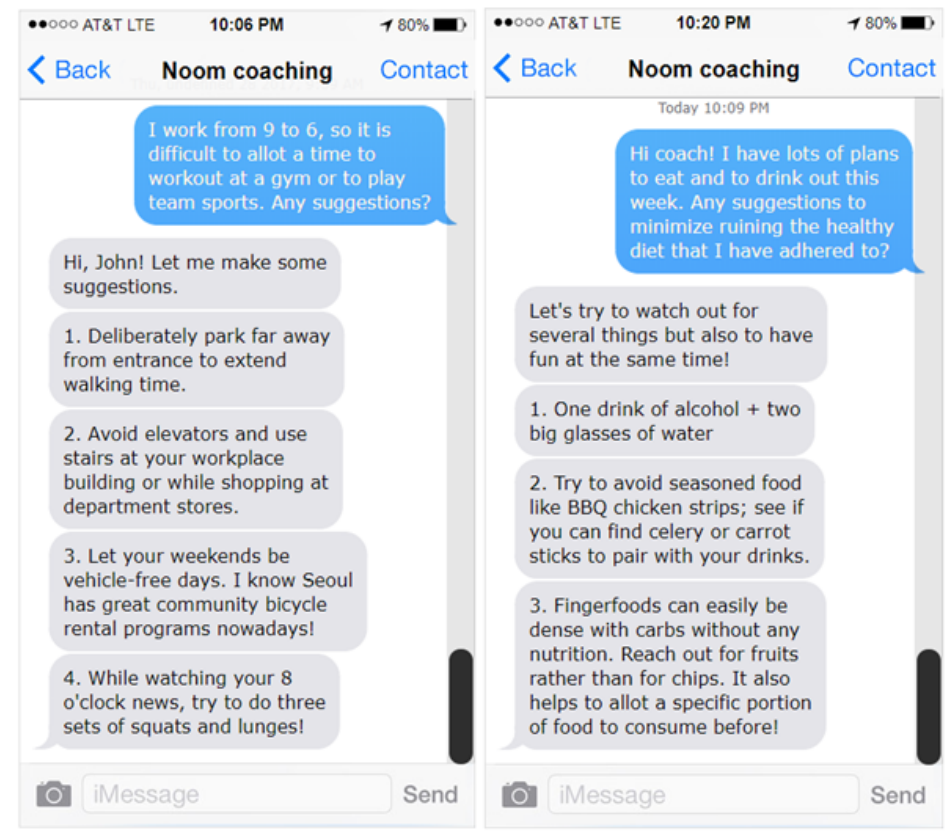
Figure 2. Example of personalized